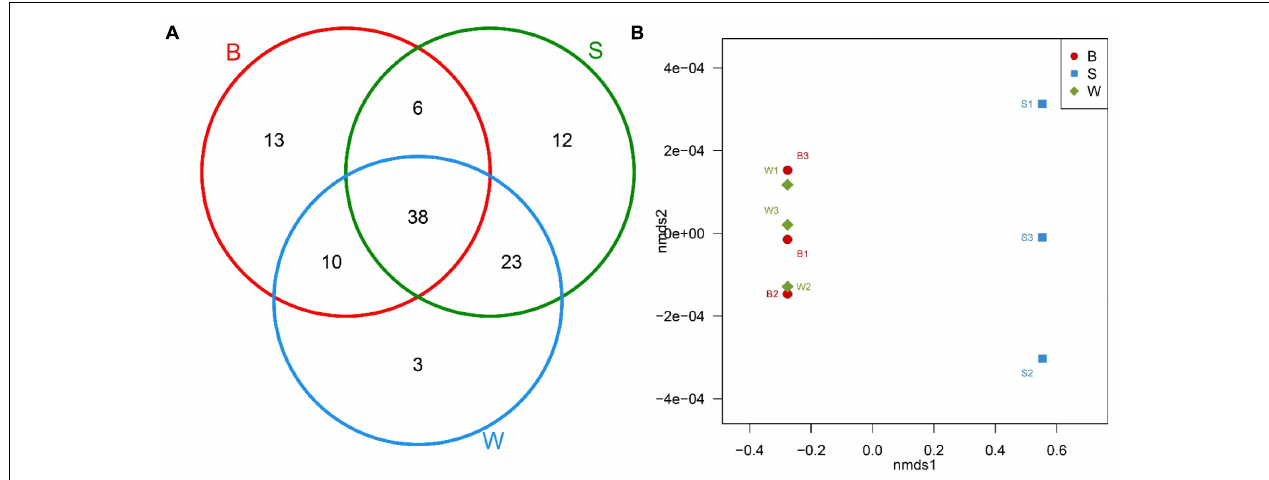
FIGURE 4 | Bacterial communities comparison and shared OTU analysis across nine samples. (A) Venn diagram showing the unique and shared OTUs in different starters. (B) Non-metric multidimensional scaling (NMDS) plot generated using Bray distances between samples of three types of starters performed at the genus